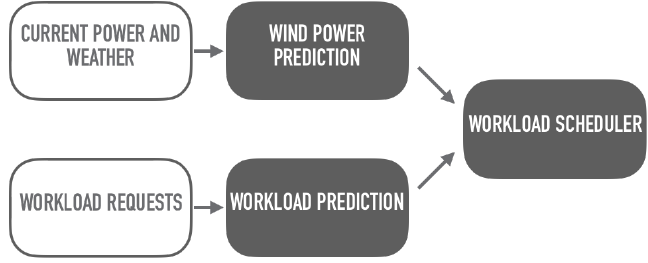
Figure 1. Architecture of the workload